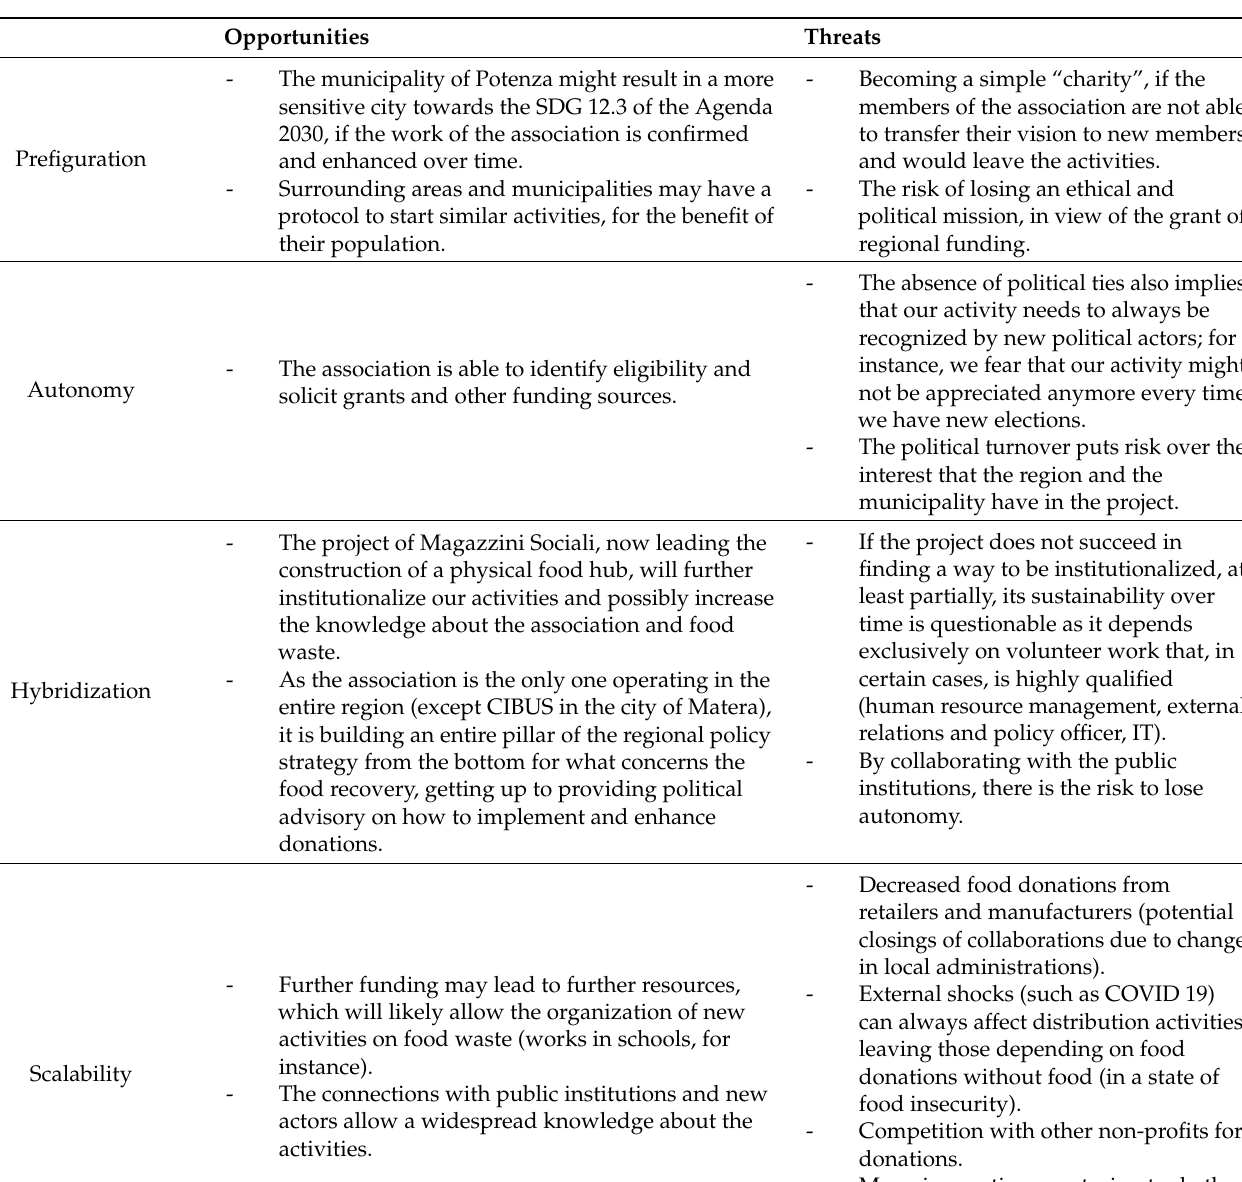
Table 2. Opportunities and threats of the project within the PAHS analytical